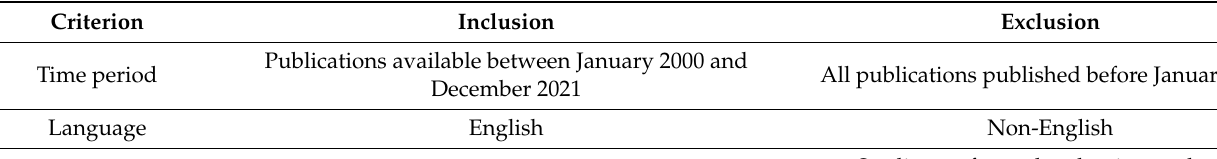
Table 1. Inclusion and exclusion